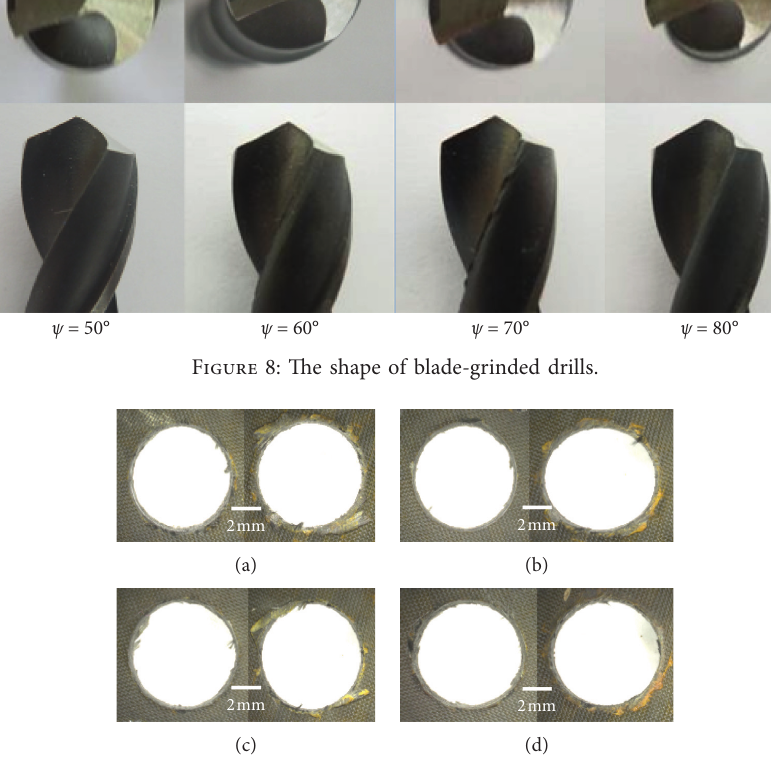
Figure 9: The photos of holes drilled by each drill. (a) ψ � 50 ° . (b) ψ � 60 ° . (c) ψ � 70 ° . (d) ψ � 80 ° .